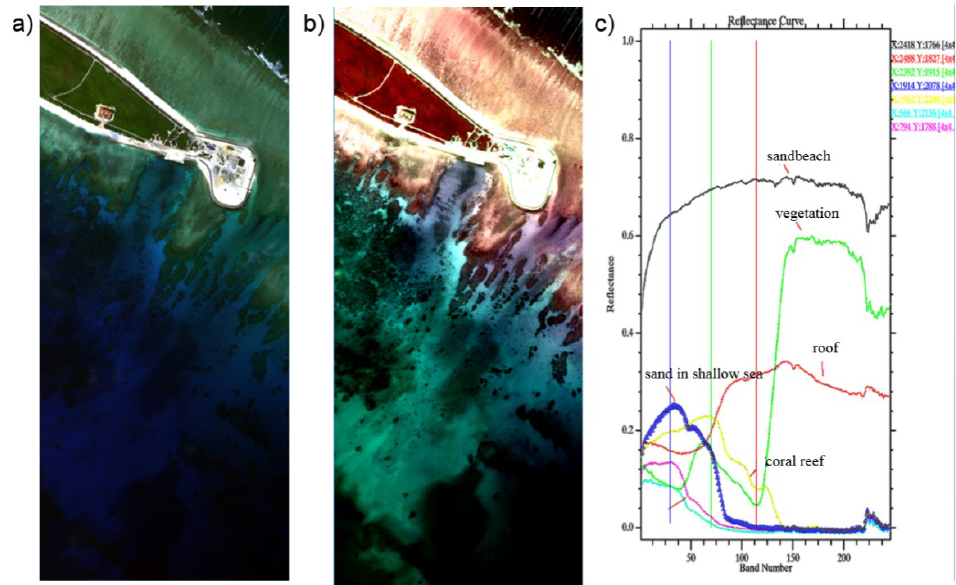
Figure 17. Hyperspectral image of island with atoll ((a) and (b) show the RGB image at different spectral channel, and (c) shows the reflectance curve of some typical targets). Sensors 2019 , 19 , x FOR PEER REVIEW